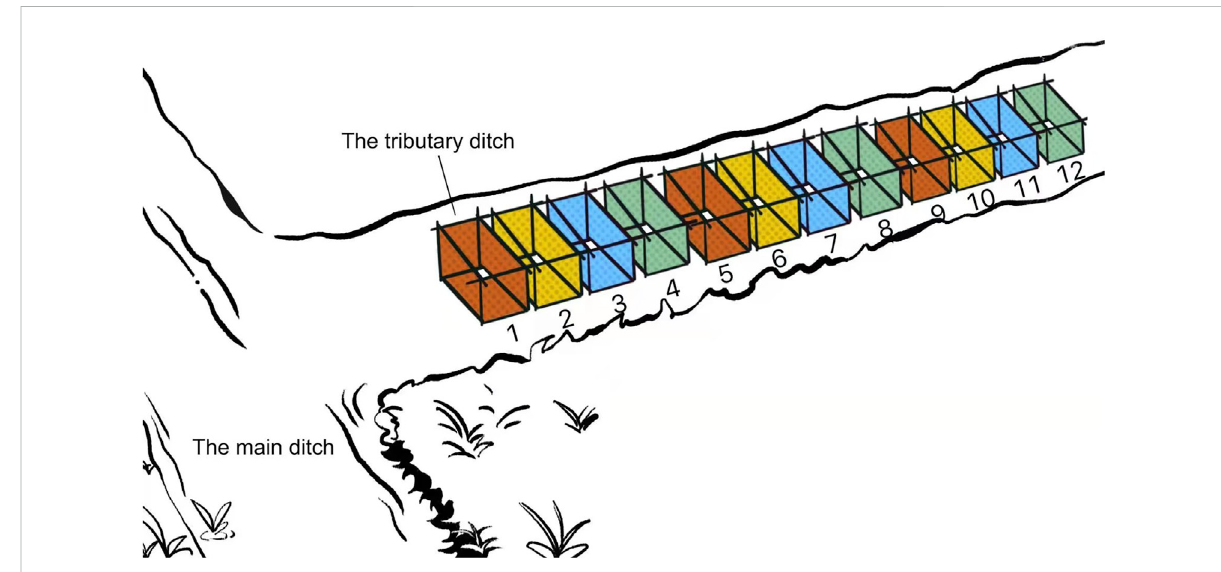
FIGURE 4 Separation frame arrangement and grouping in Experiments 3 and 4.